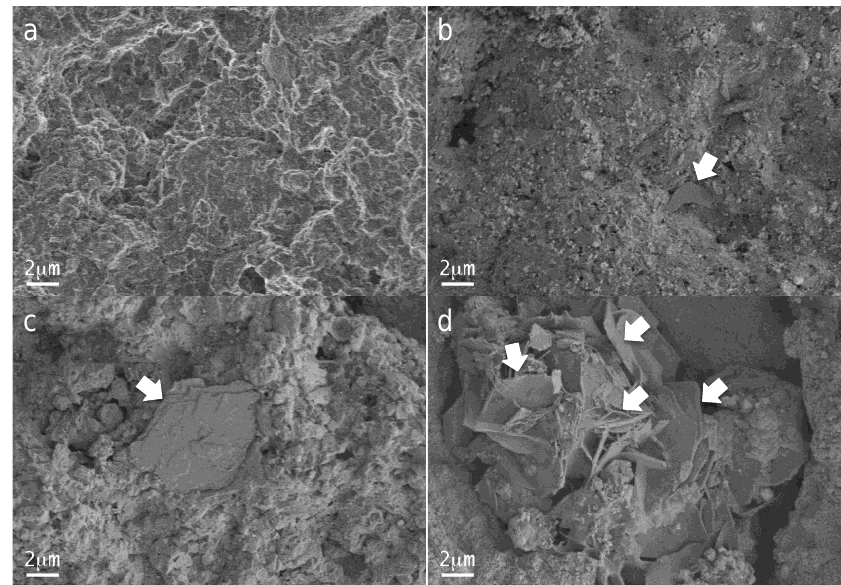
Figure 5. FEG-SEM secondary electron micrographs of hydrated MTA Repair HP material after different setting time period: ( a ) 12 min; ( b ) 4 h; ( c ) 24 h; ( d ) 72 h. White arrows indicate plate-like features observations.